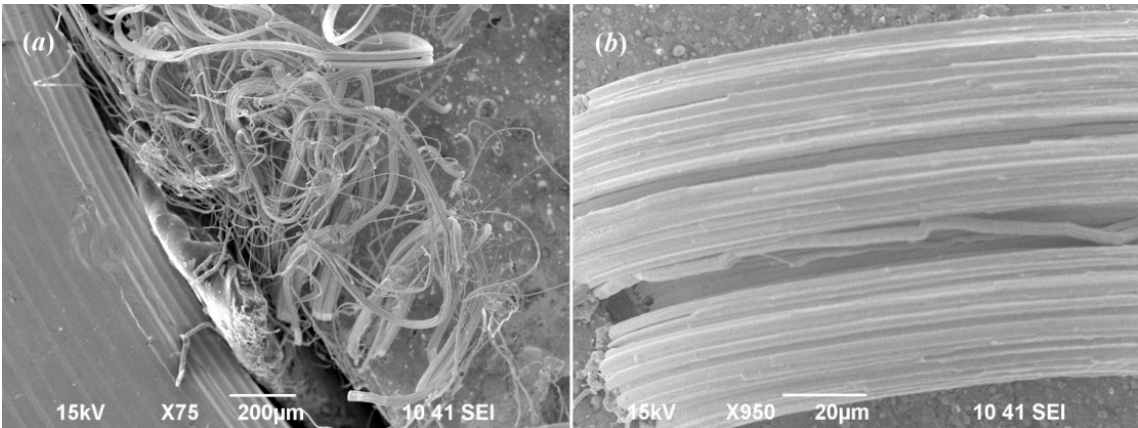
Figure 9. The surface of sample pressed from synthesized fine-dispersed Ag 2 S powder, heated at 893 K and cooled to 298 K: ( a ) long whiskers of metallic silver; ( b ) splices (aggregates) of metallic silver whiskers.